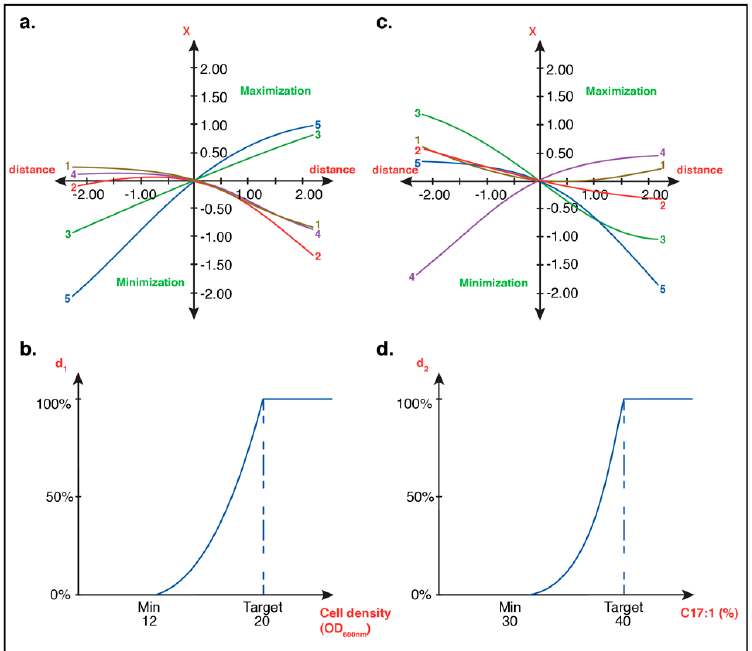
Figure 3. ( a ) Optimal path for the response to cell density (OD 600 nm ), ( b ) Desirability function for the optimization of the response to cell density (OD 600 nm ), ( c ) Optimal path for the response to C17:1 content (%), ( d ) Desirability function for the optimization of the response to C17:1 content (%).